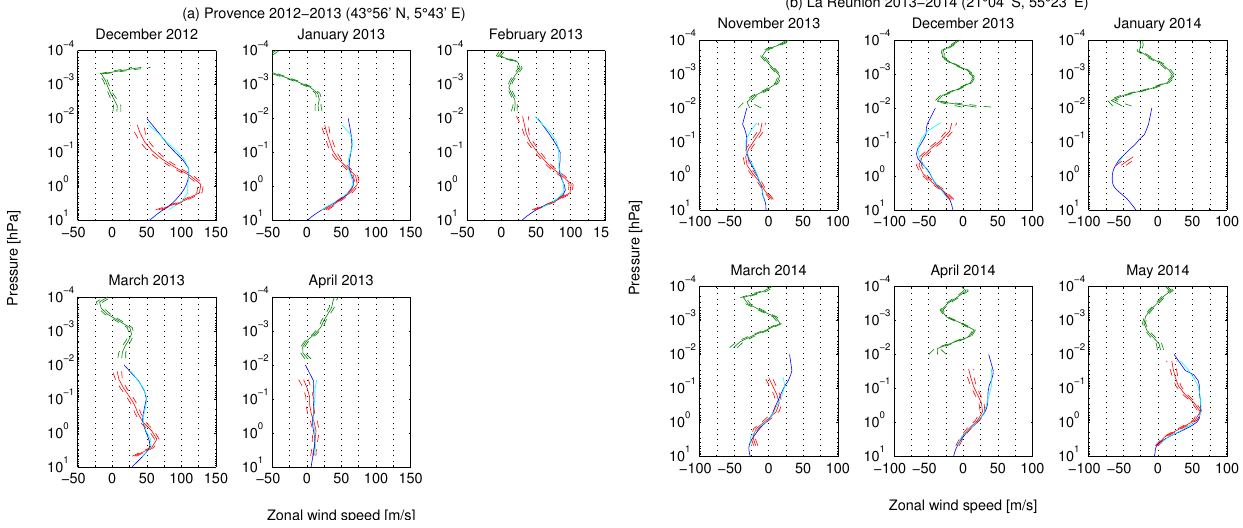
Figure 17. Monthly mean profiles of zonal wind measured by the new WIRA single sideband receiver (red) compared to ECMWF operational analysis data (blue), to the ECMWF profile convolved with WIRA’s averaging kernels (cyan) and to TIDI data (green). The dashed lines represent the error estimates for the averaged measurement data.